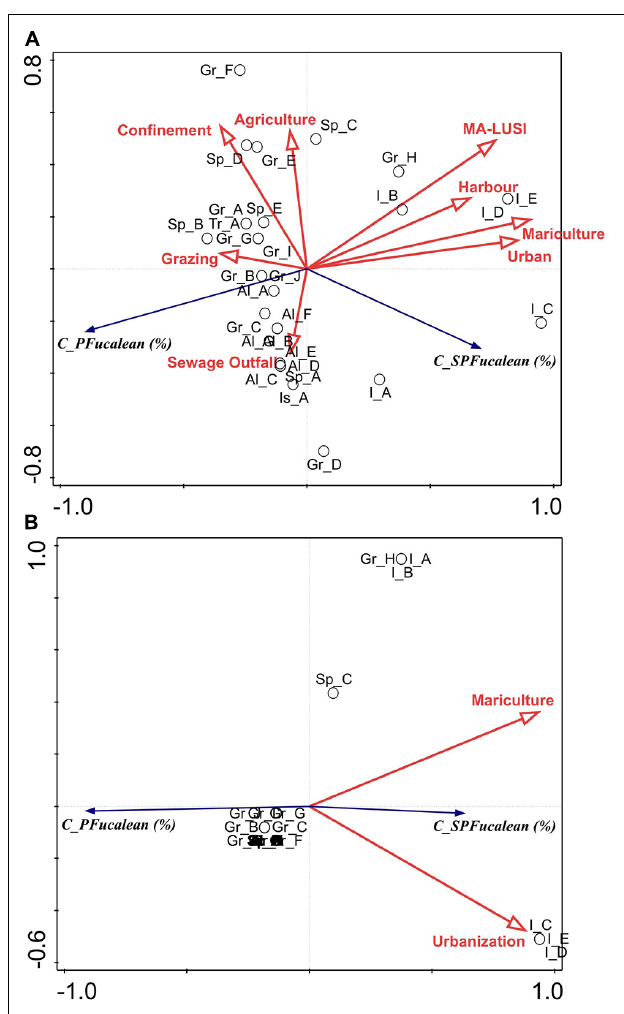
FIGURE 7 | Graph plots of the full (A) and forward selection (B) models of redundancy analysis (RDA) between percentage cover of perennial fucalean species (C_PFucalean) and semi-perennial C. compressa, and C. compressa var. pustulata (C_SPFucalean) found in the sampled locations, and the main anthropogenic and biological (grazing)